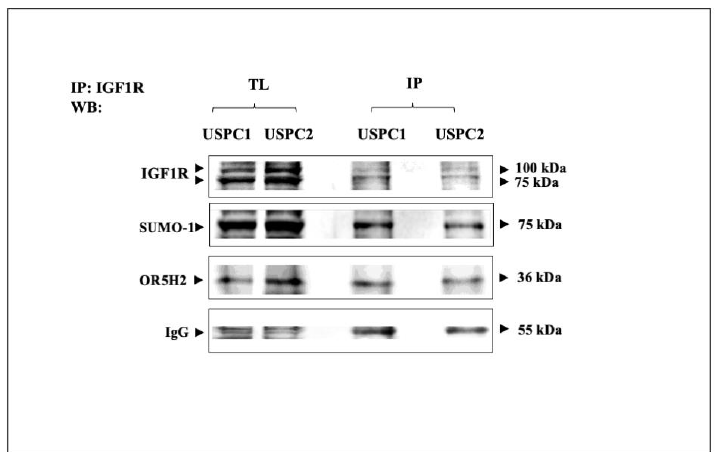
Figure 6. Analysis of physical interactions between IGF1R and OR5H2. USPC1 and USPC2 cells were lysed and immunoprecipitated with anti-IGF1R. Precipitates were electrophoresed through 10% SDS-PAGE, blotted onto nitrocellulose filters, and immunoblotted with anti-OR5H2, anti- IGF1R or anti-Sumo1. IP, immunoprecipitation; WB, Western blotting; TL, total lysate. Results of a typical experiment repeated twice with similar results are